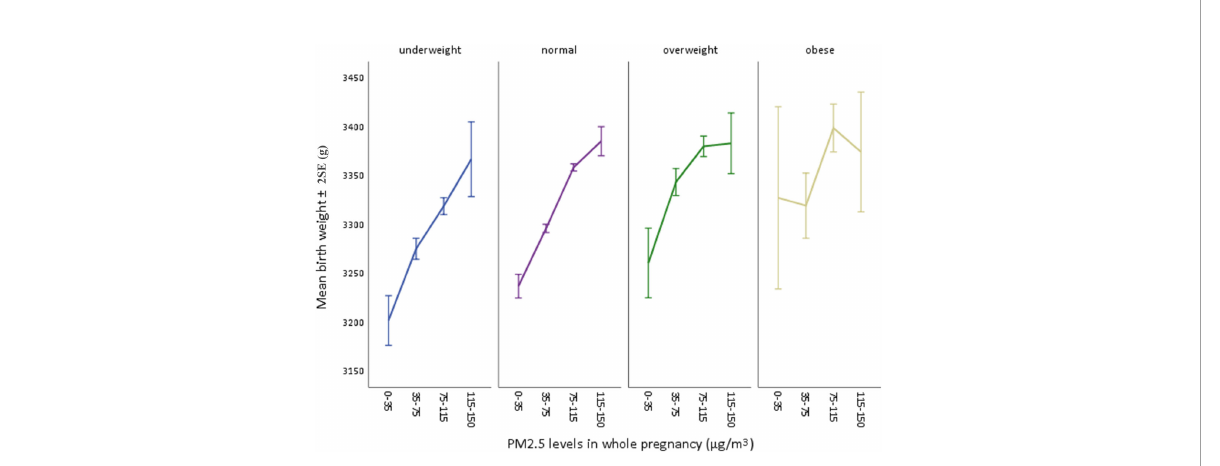
FIGURE 3 Mean birthweights by each PM 2.5 level in four BMI subgroups. Four PM 2.5 levels were: 0-35 (Chinese guideline II), 35-75 (mild), 75-115 (moderate), 115-150